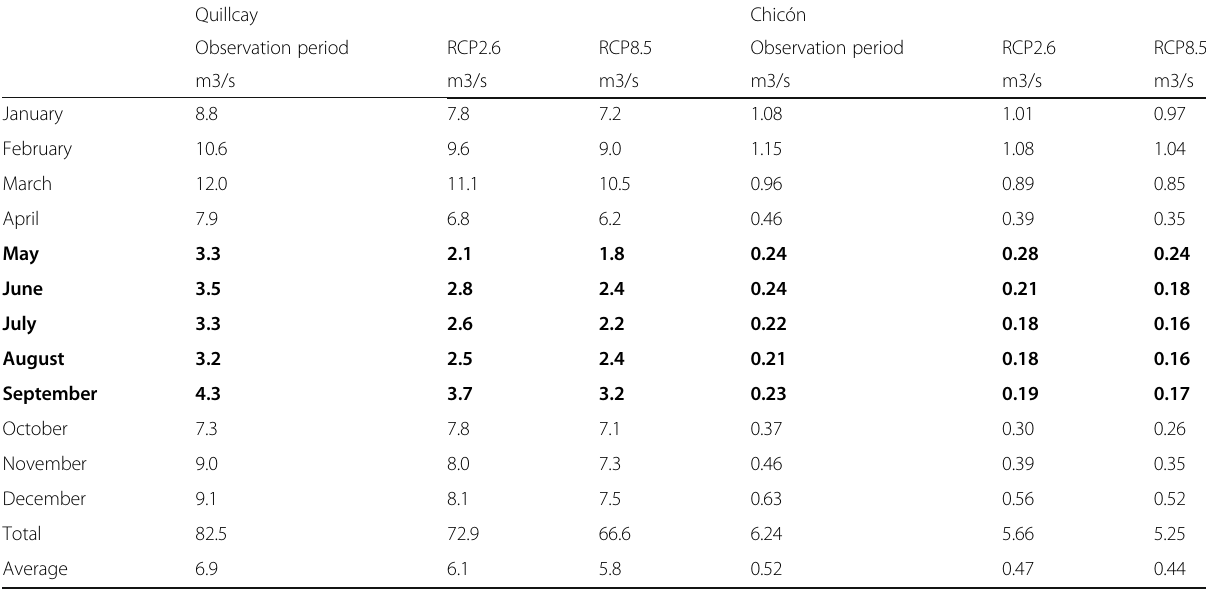
Table 2 Monthly water balance for the Quillcay and the Chicón catchment based on the historic simulated data and extended for the RCP scenario 2.6 and 8.5 for the end of the 21st centtury. Dry season approximately May to September, wet